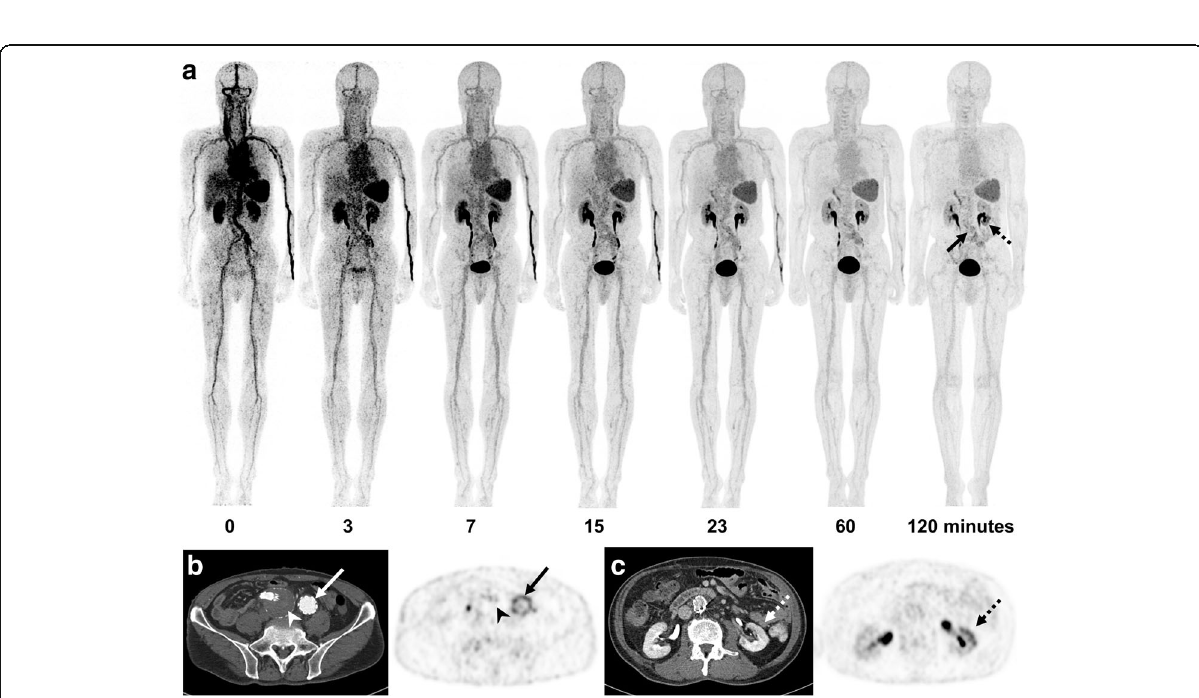
Fig. 2 18 F-GP1 PET/CT and CT images of a 73-year-old man who had undergone endovascular abdominal aortic aneurysm repair surgery. Anterior maximum intensity projections of 18 F-GP1 PET/CT show positive 18 F-GP1 accumulation in the inner surface of abdominal aortic graft (arrow) and the lower portion of the left kidney (dotted arrow), which are increasingly distinct in later images as background 18 F-GP1 activity clears over time via urinary and hepatobiliary excretion ( a ). Transaxial CT and PET images show increased 18 F-GP1 uptake in the inner surface of the left iliac artery graft ( b , arrows), but no 18 F-GP1 uptake in the chronic intraluminal thrombus in the right iliac aneurysmal sac ( b , arrow heads). Additional positive 18 F-GP1 uptake is observed in the non-enhancing renal ischaemic area involving the lower portion of the left kidney ( c , dotted